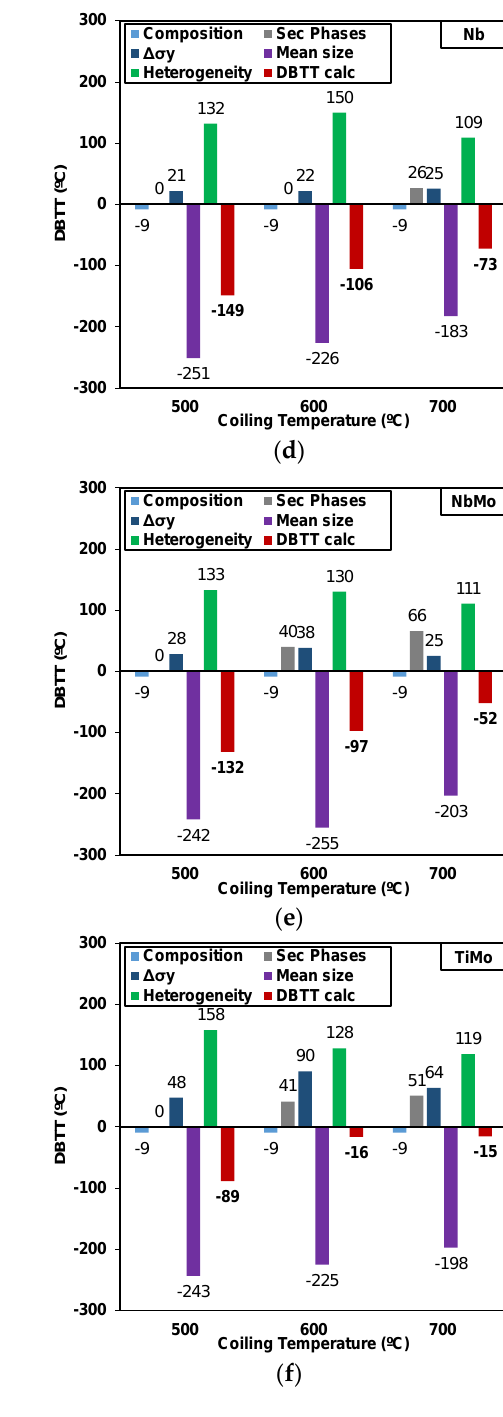
Figure 10. ( a – c ) Individual contributions (grain size, dislocations, MA islands, precipitation and composition) weighted according to Equation (3) for each coiling temperature. ( d – f ) Estimated contributions to the DBTT as a function of the coiling temperature and for all the microalloyed steels: ( a , d ) Nb; ( b , e ) NbMo; and ( c , f ) TiMo.